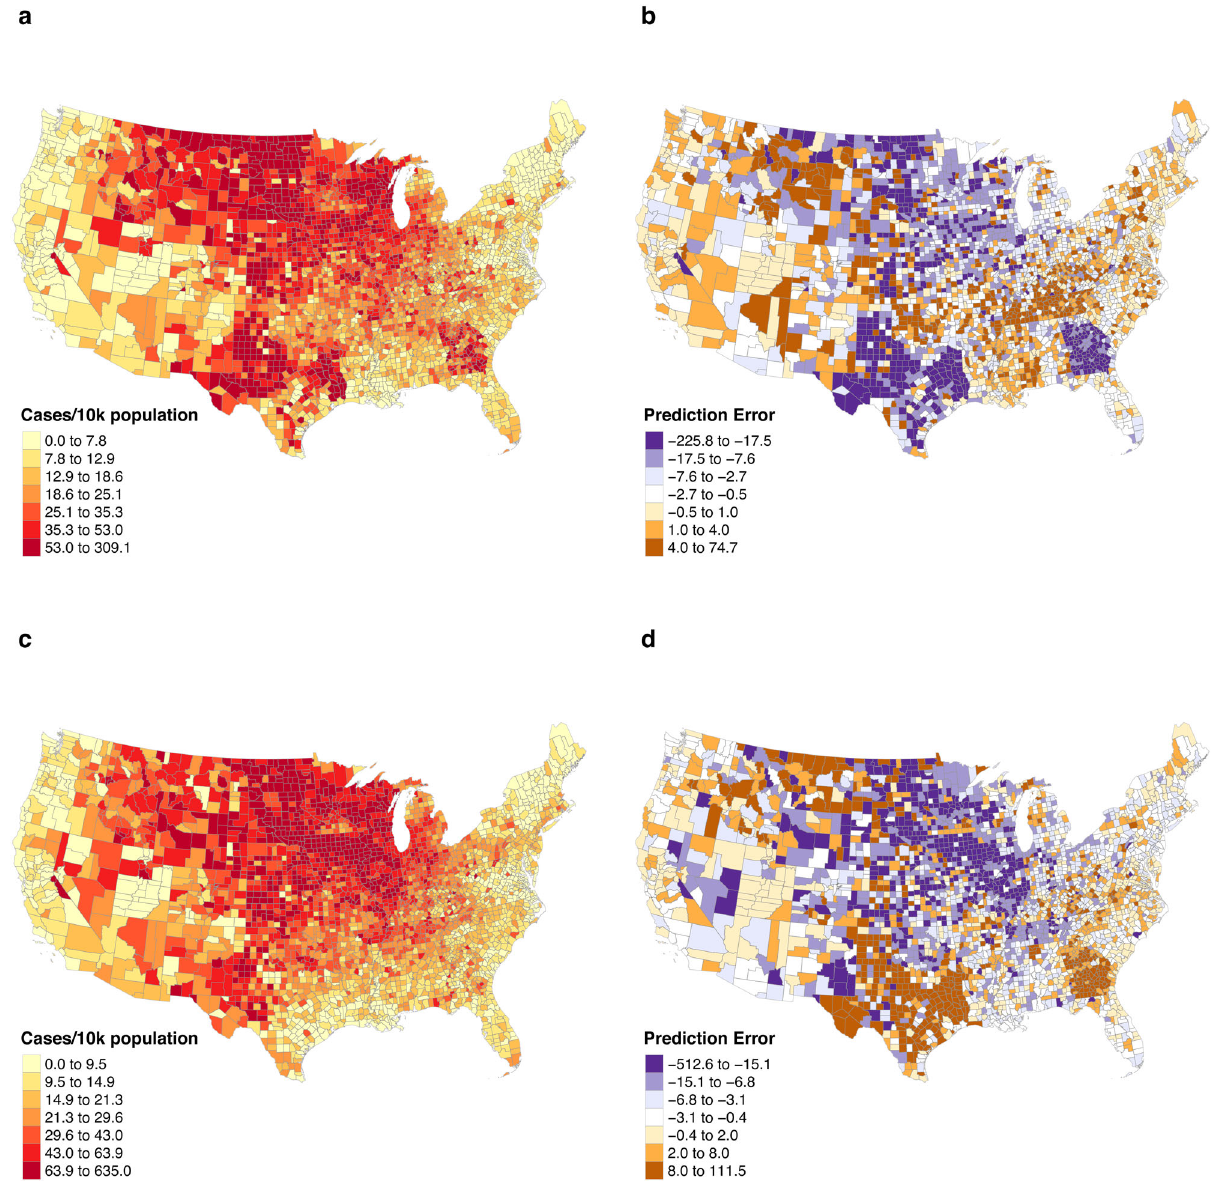
Fig. 4 A map of COVID-19 cases per 10k population and errors in predicting them. a The number of con fi rmed new cases per 10k population over the week ahead of forecasting date Nov. 1, 2020. b Prediction errors for the same forecasting date. c Number of new cases over the week ahead of the Nov. 8, 2020 forecasting date. d Prediction errors for the same forecasting date. The pattern of errors in Georgia, Texas, and Kentucky fl ips from Nov. 1 to Nov. 8, indicating potential lags in testing and reporting. The purple-shaded counties in the error maps are those with model underestimation of new cases, and the brown shades indicate overestimations of observed